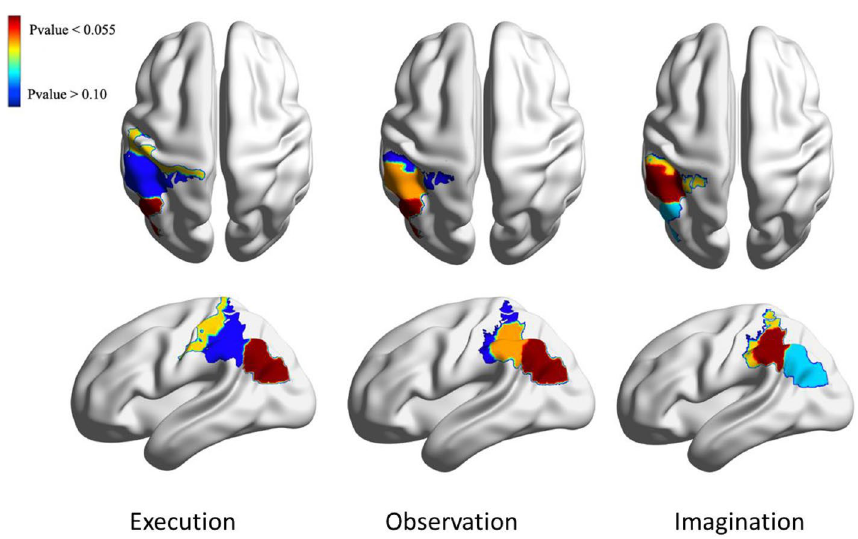
Figure 5. Extracted brain regions associated with execution, observation, and imagination. The axial view is on the top right, while the sagittal view is on the bottom right. The color bar refers to the p -values of the correlations in the region. Moderate correlations were found over the left IPL (r = 0.39; p = 0.059), left POCG (r = 0.38, p = 0.061), and left SMG (r = 0.29, p = 0.069) during ME; over the left IPL (r = 0.46; p = 0.053), left SMG (r = 0.38; p = 0.059), and left POCG (r = 0.32; p = 0.066) during MO; and over the left SMG (r = 0.50, p = 0.059), left POCG (r = 0.41; p = 0.061), and left IPL (r = 0.20, p = 0.063) during